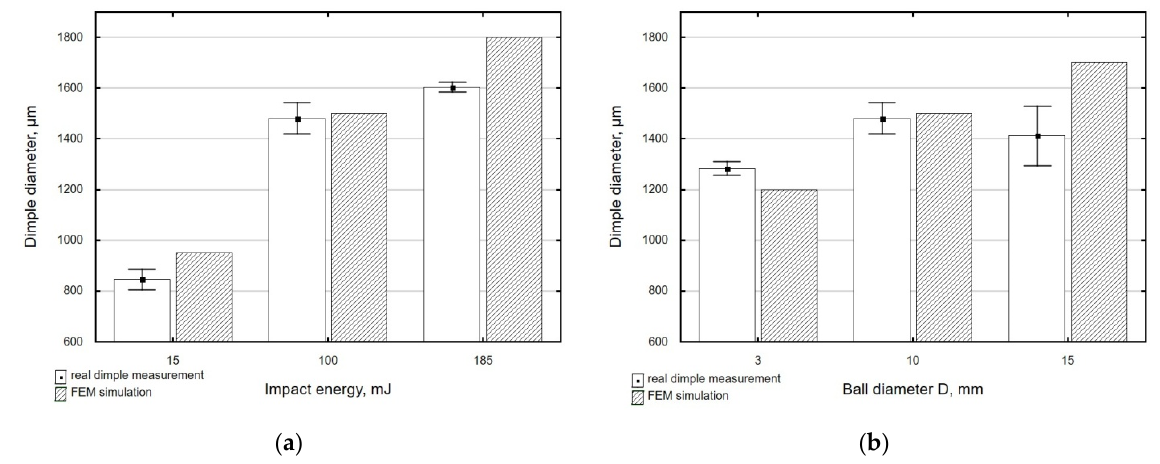
Figure 16. Comparison of the real and FEM numerical simulation dimple diameters as a function of: ( a ) impact energy, ( b ) shot-peening element diameter.